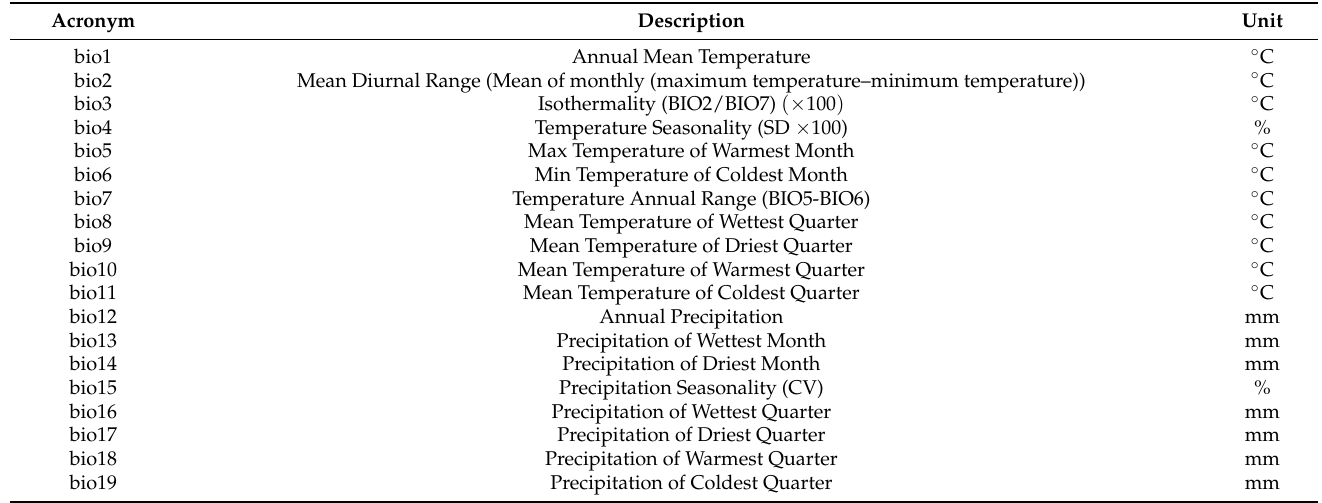
Table 1. Bioclimatic variables used in this